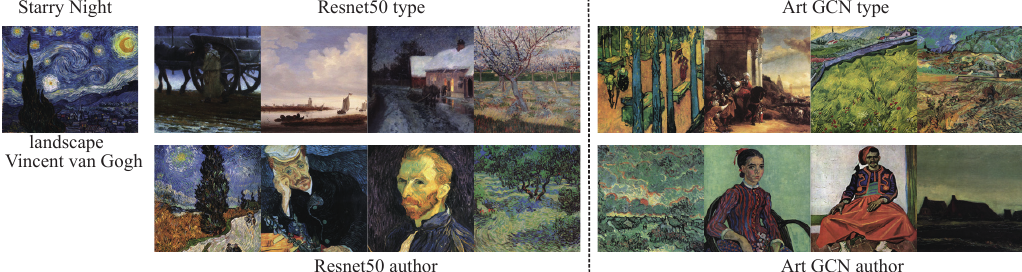
Figure 7. Similarity results for the painting Starry Night by Vincent Van Gogh.